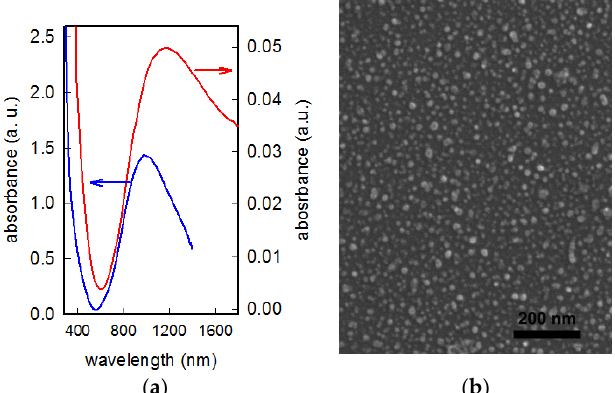
Figure 2. ( a ) UV–Vis spectrum of a CuS NP-glass sample (red line, absorbance on right axe) compared with the spectrum of the colloidal suspension used for functionalization (blue line, absorbance on left axe); ( b ) SEM image of the CuS NP-glass sample.